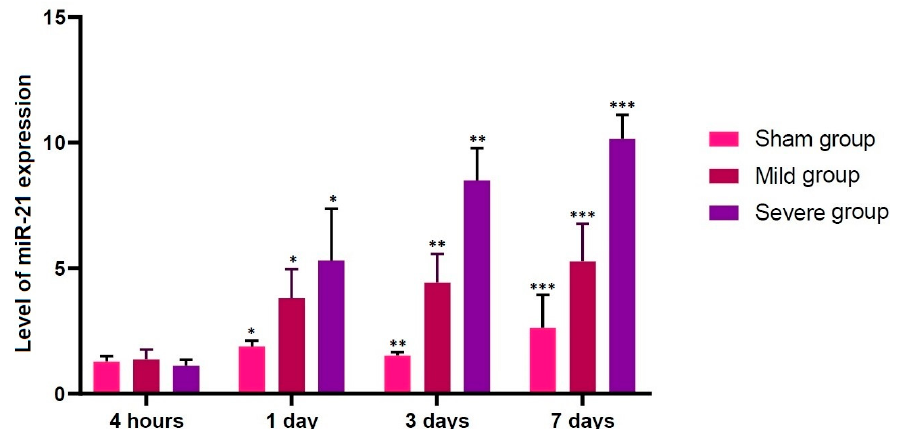
Figure 4. Up-regulation of miR-21. No di ff erences in the level of miR-21 expression were found at the first time point studied (4 h post-lesion) between the three experimental groups, whereas such di ff erences were significant at all the other time points ( p < 0.05). Asterisks indicate significant di ff erences between the same ones at p < 0.05.